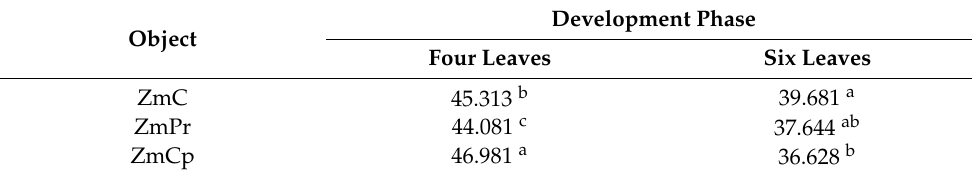
Table 2. Zea mays leaf greenness index (SPAD). Object